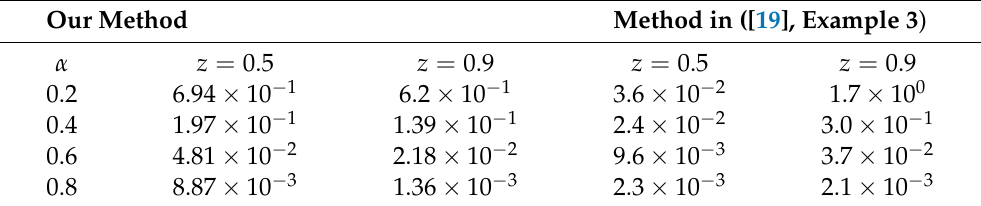
Figure 6. Exact and approximate solutions of Example 4 are compared at different scale levels. Table 8. Approximate results of Example 4 at various values of α